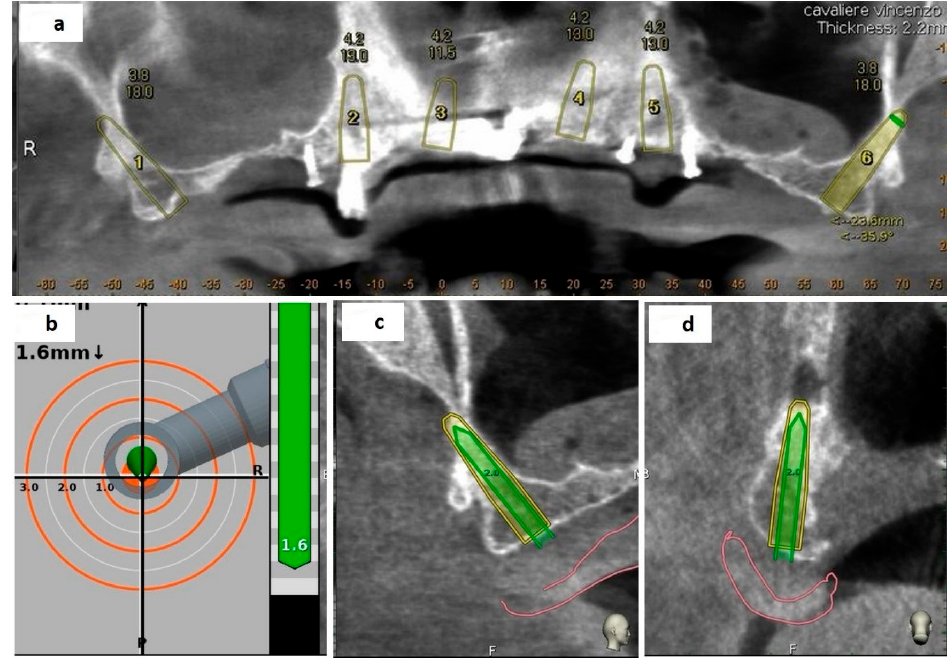
Figure 11. The screen-views during osteotomy: panoramic view ( a ), target view and depth indicator